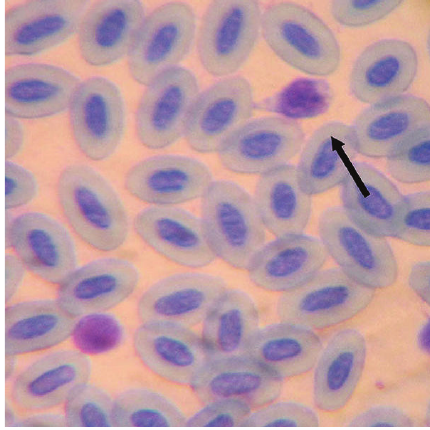
Figure 4: Macrogametocyte of Leucocytozoon sp.